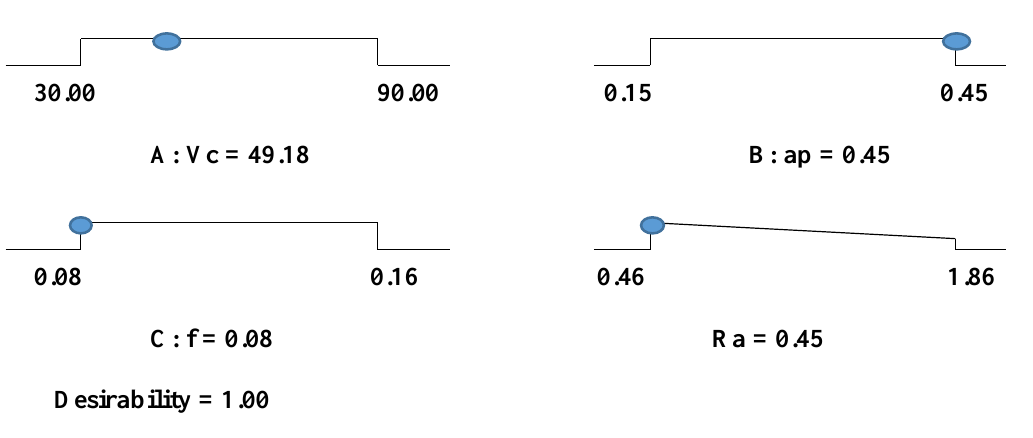
Fig. 23. 3D surface plot (a) and contour plot (b) for Desirability case (3)